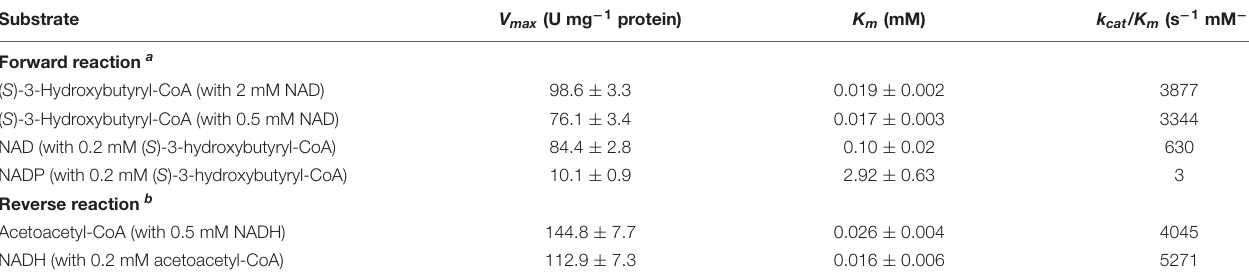
TABLE 1 | Catalytic properties of heterologously produced ( S )-3-hydroxybutyryl-CoA dehydrogenase Nmar_1028. Substrate Forward reaction a